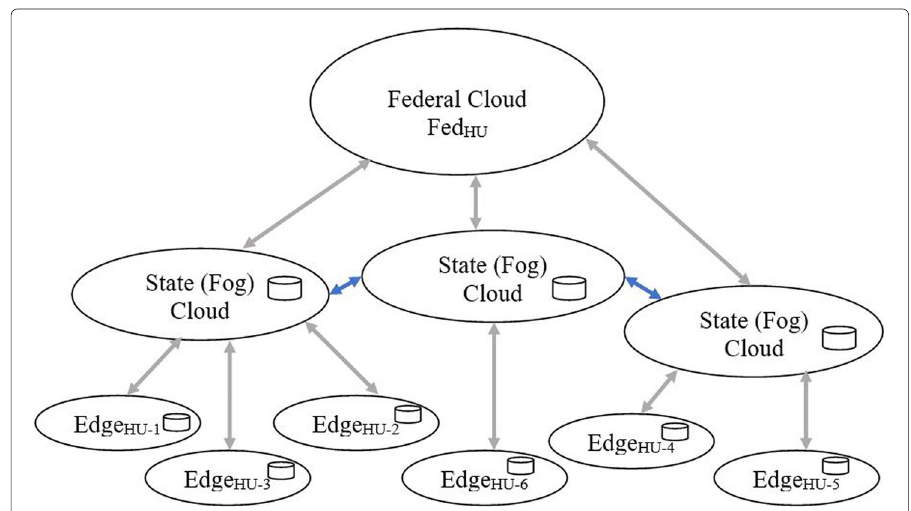
Fig. 4 BFC 2 block vault locations (Malomo et al.